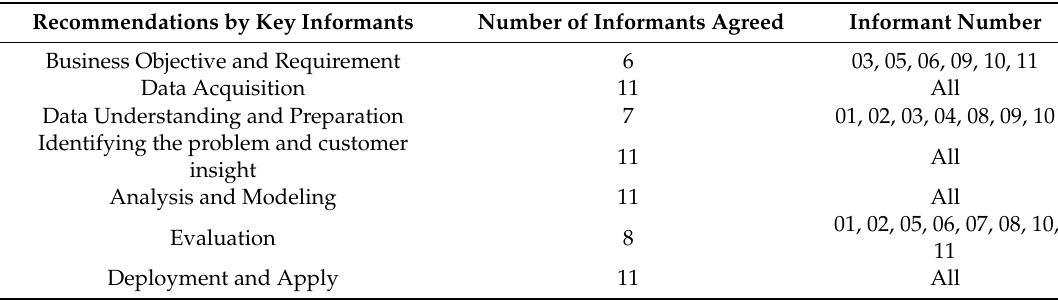
Table 3. Process prioritization for big-data analytics for service